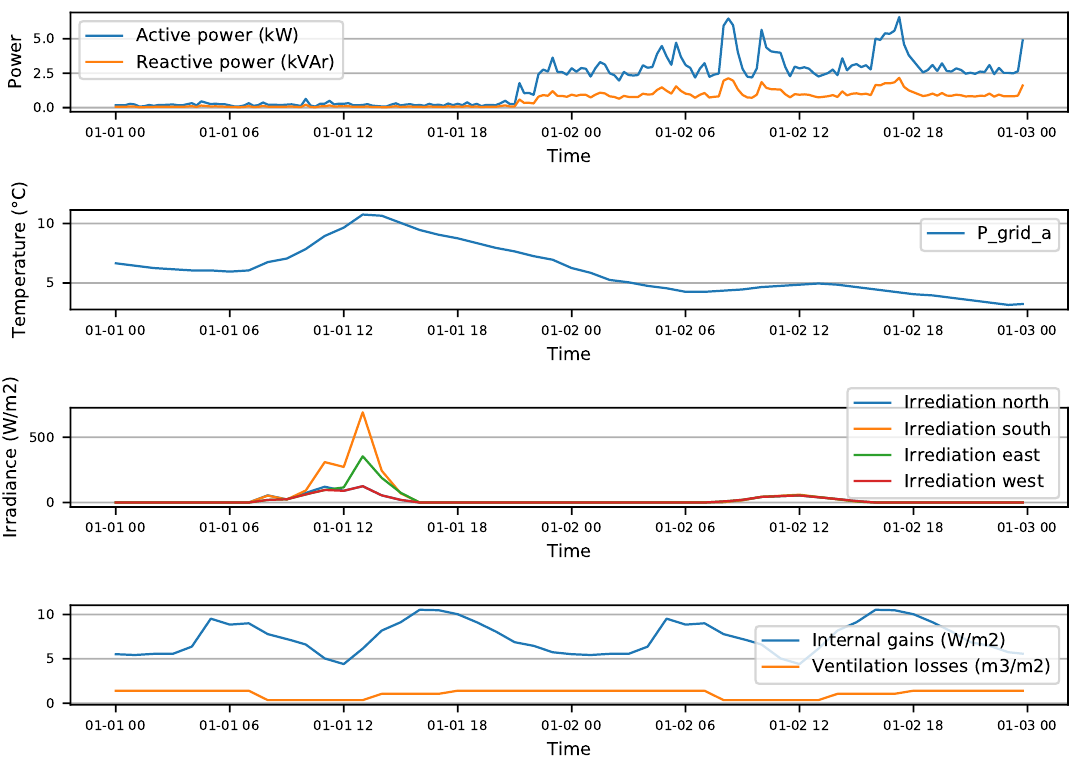
Figure 2. Profiles of disturbances applied to smart HEMS. On the x-axis, data time format is MM-dd HH. Data is from 01-01-2018 00:00:00 to 01-02-2018